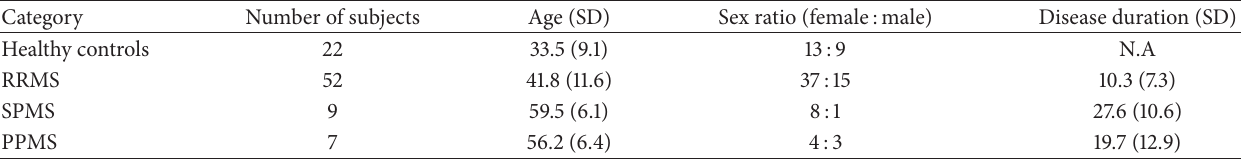
Table 1: Demographic characteristics of subjects in the cross-sectional cohort.